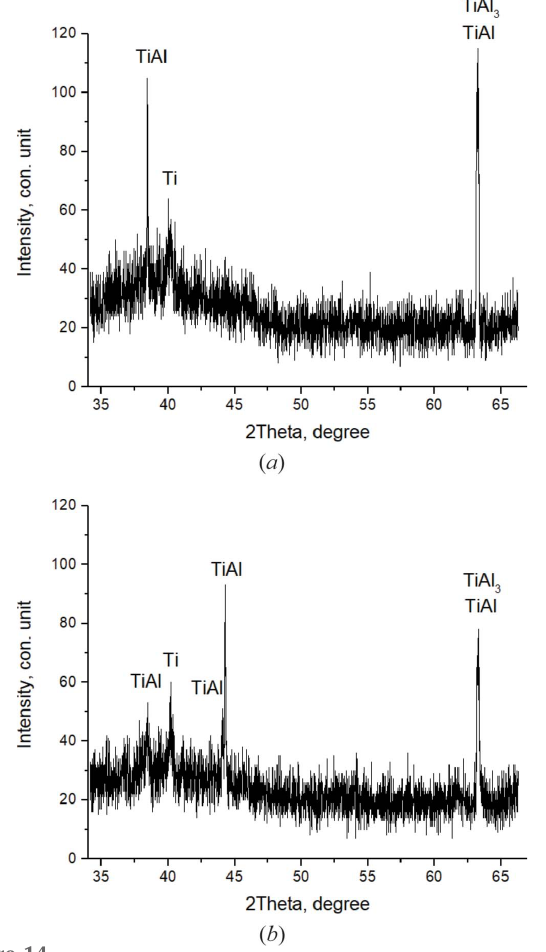
Figure 14 Diffractograms of the 36th ( T = 1405 (cid:3) C) ( a ) and the 39th ( T = 1385 (cid:3) C) ( b ) shots